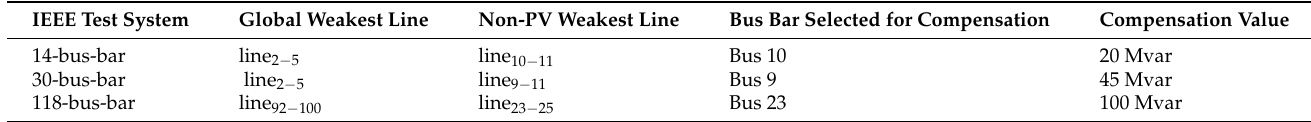
Table 4. Algorithm results for the three case